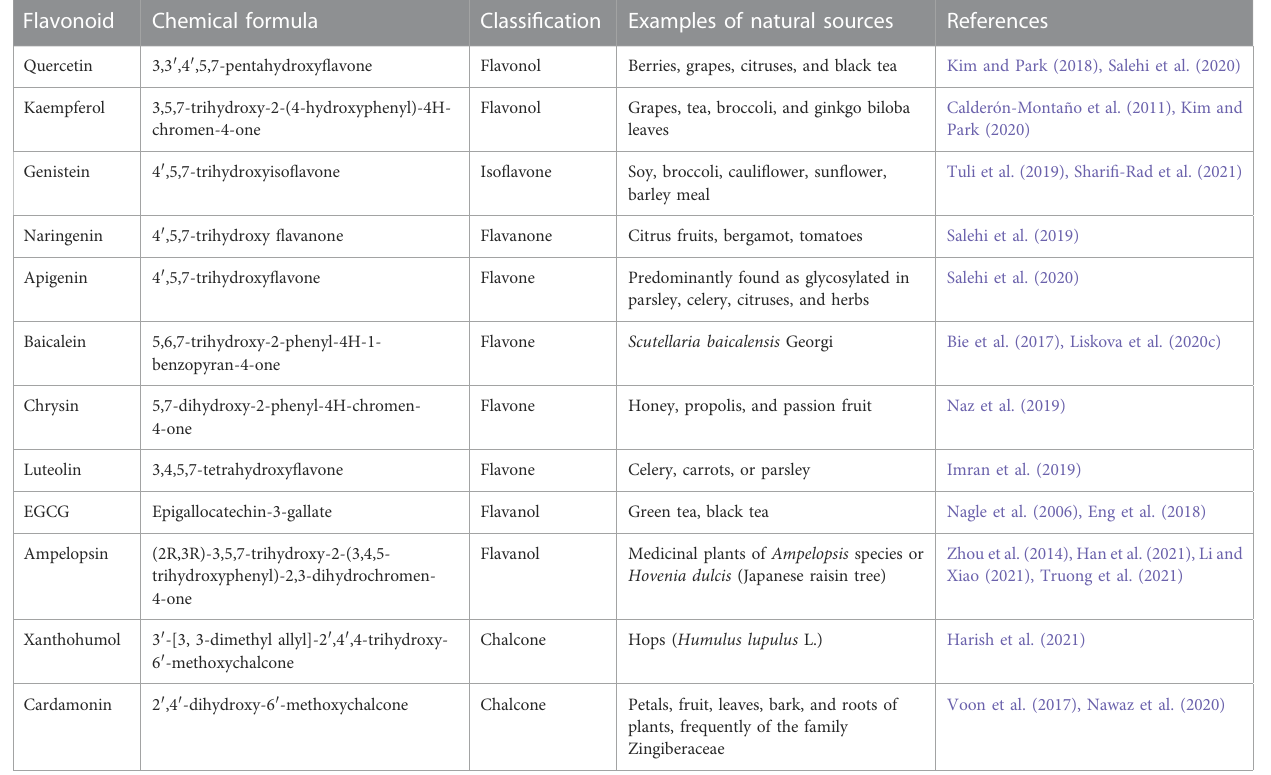
TABLE 1 Classi fi cation, chemical formula, and natural sources of selected fl avonoids.